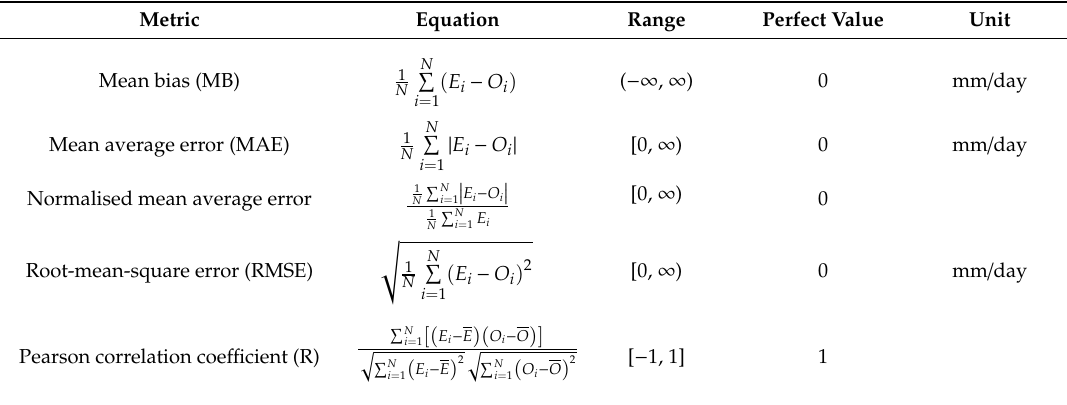
Table 2. Summary of metrics used.